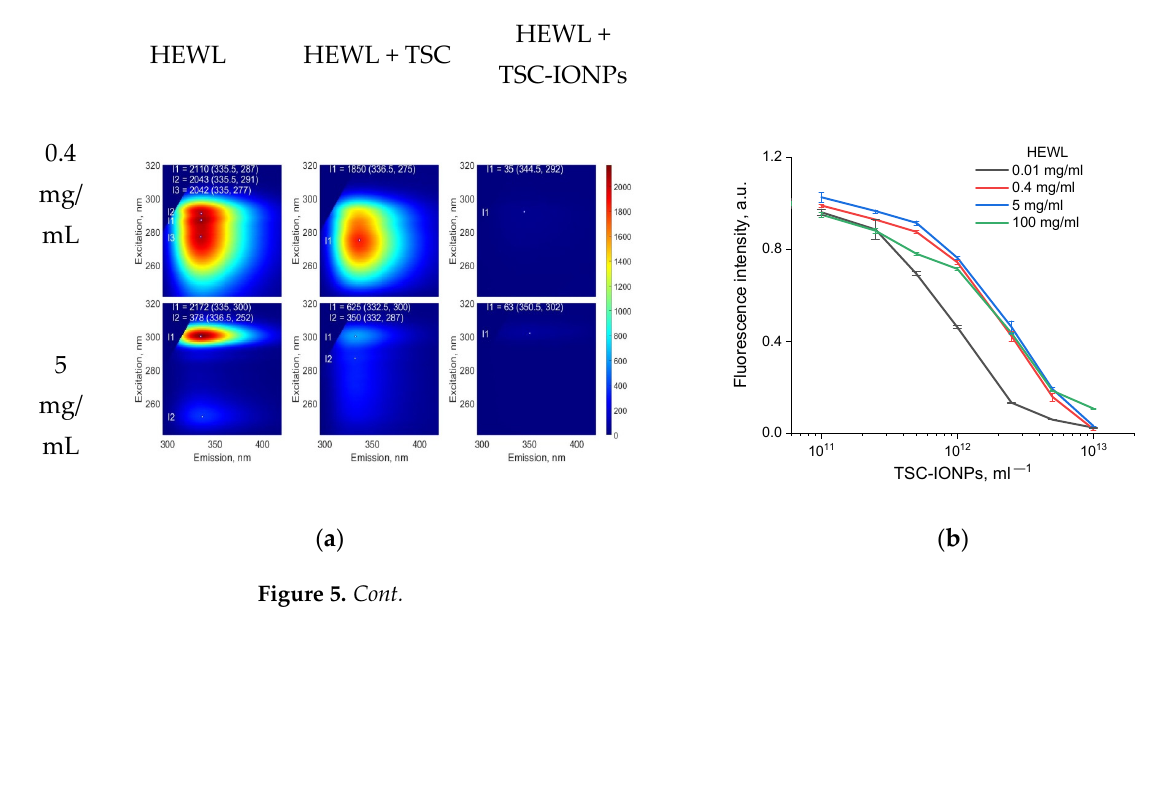
concerning water.